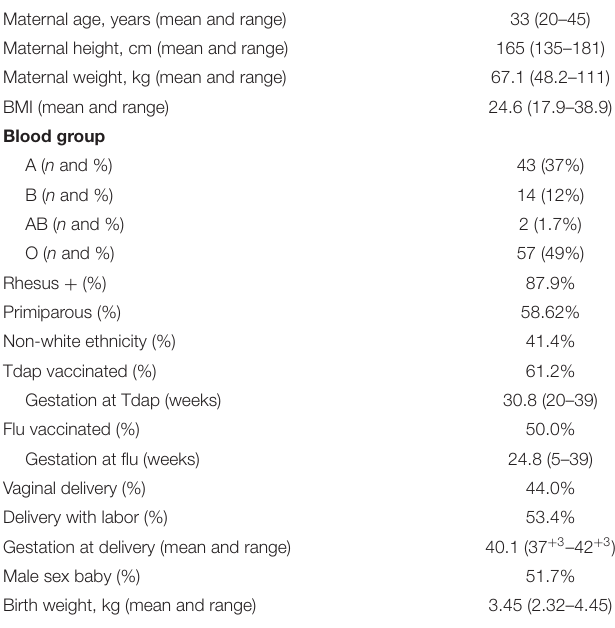
TABLE 1 | Maternal and infant characteristics.